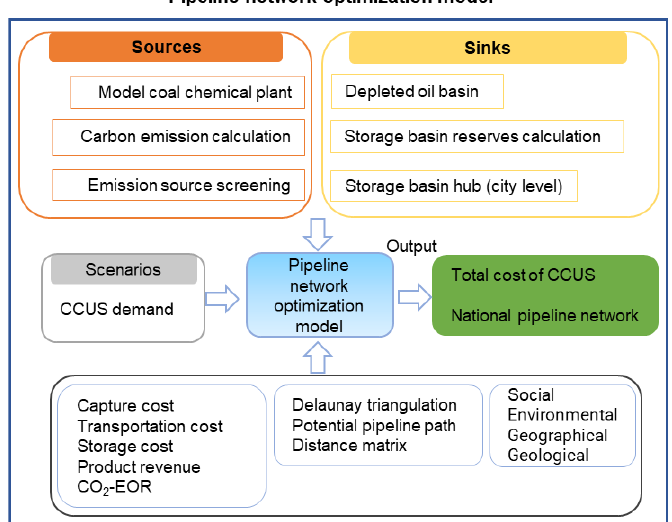
Figure 1. Research framework.